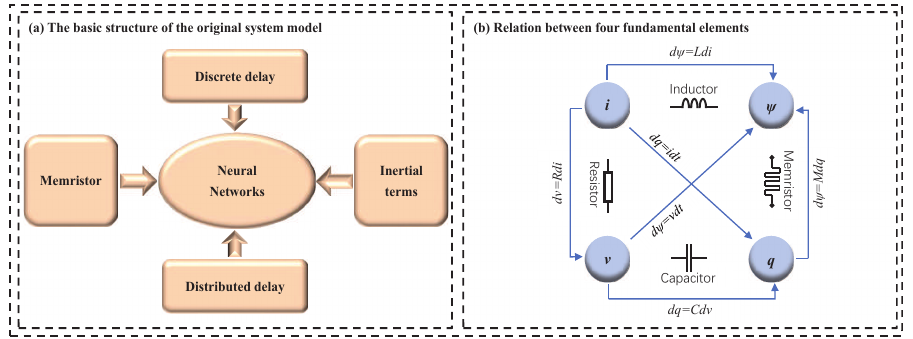
Figure 1. System constitution and four fundamental